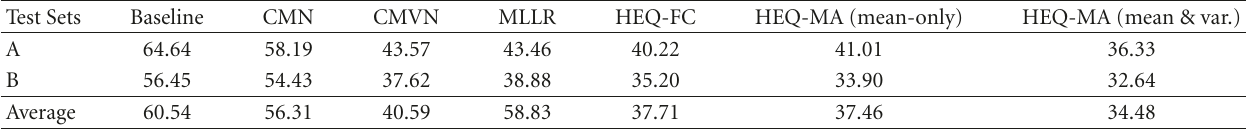
Table 2: Word error rates (%) on the Korean POW task (Results are averaged between 0 and 20dB